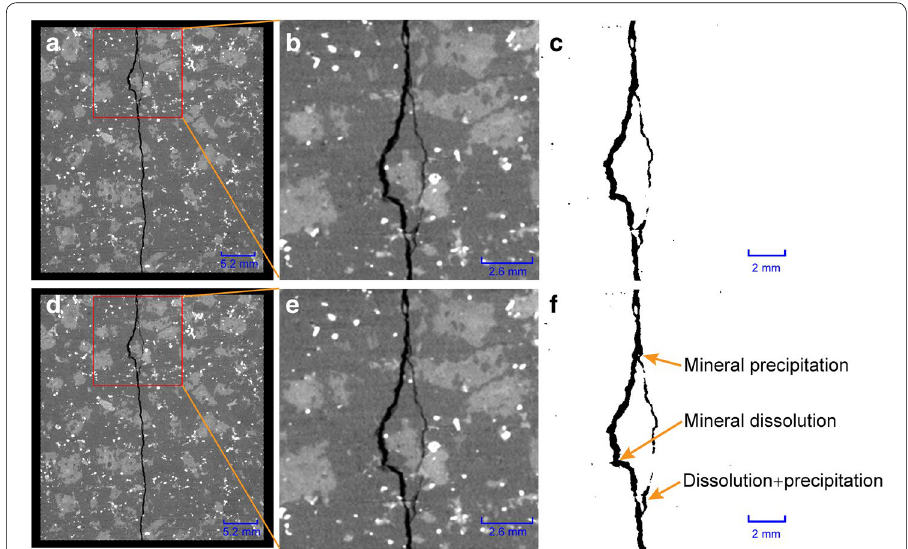
Fig. 13 CT scan results of rock fractures before ( a , b , c ) and after ( d , e , f ) the experiment